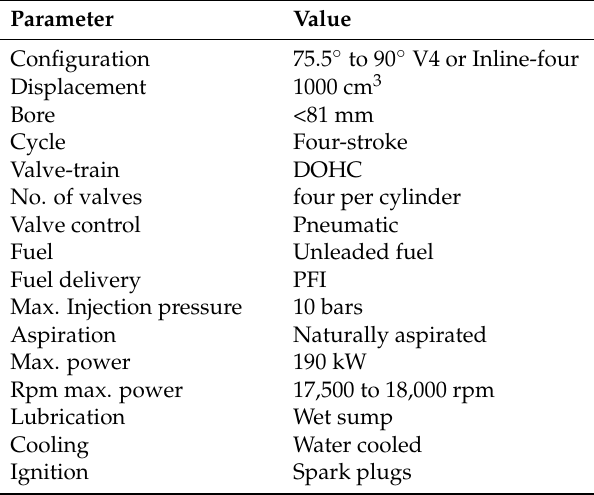
Table 1. Moto-GP